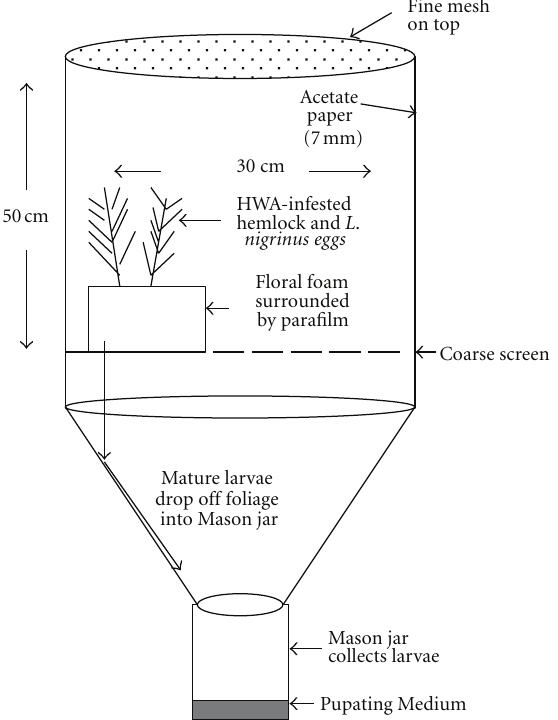
Figure 1: Diagram of the form and function of the Laricobius nigrinus larval rearing